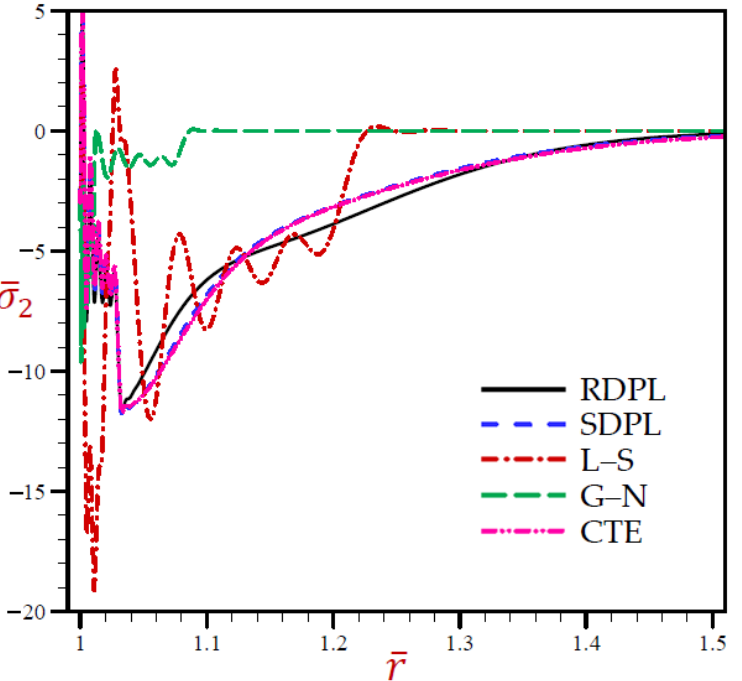
Figure 6. The circumferential stress σ 2 through radial direction of a spherical hole presenting to all models.